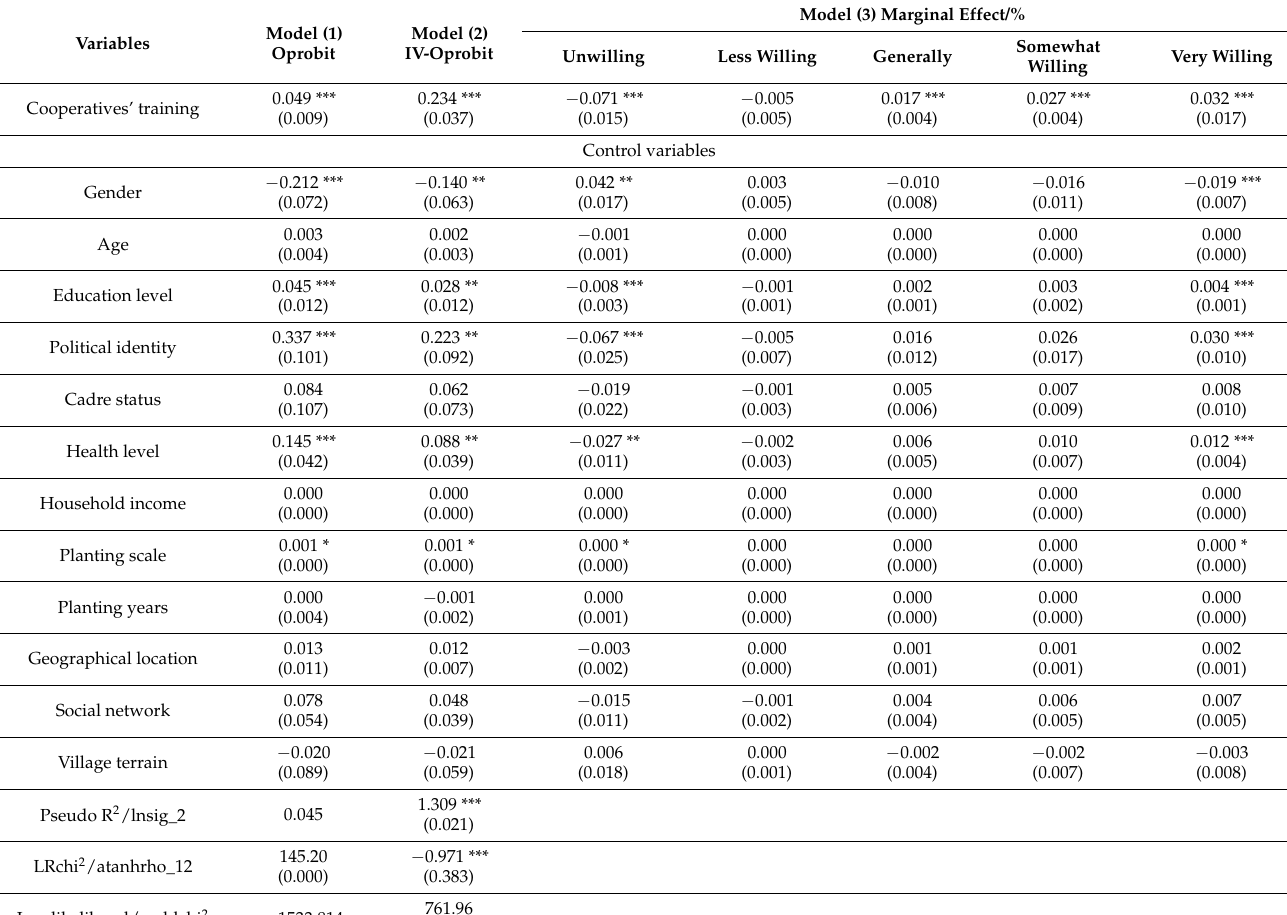
Table 3. The impact of farmer cooperatives’ training on members’ willingness to adopt green production